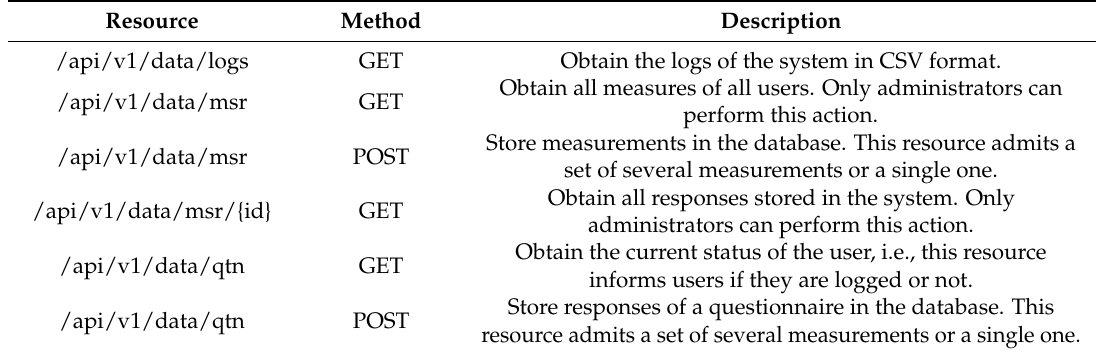
Table 4. Resources provided by the Data Management